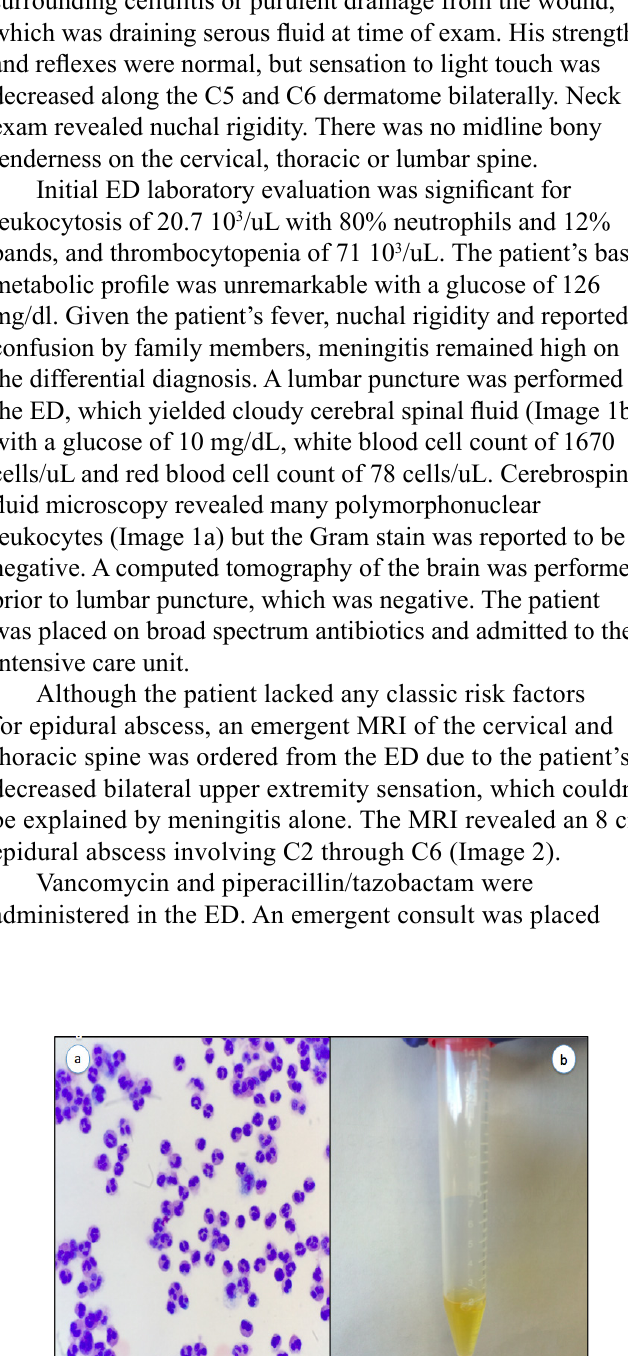
Image 2. Left: C spine sagittal T2 weighted image taken on day of presentation with lesion from C2-C5. Right: C spine sagittal T2 weighted image 3 days post-admission with larger lesion now from